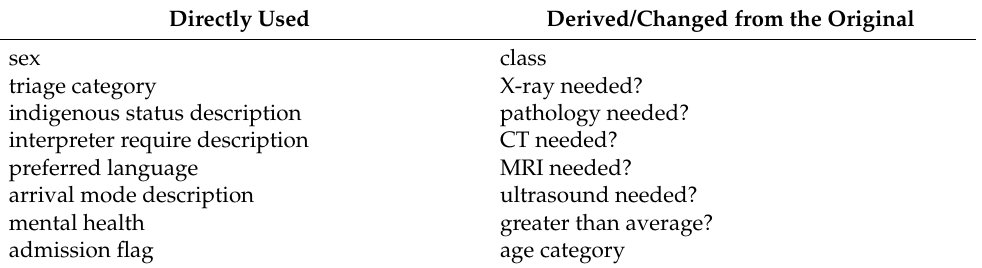
Table 1. Summary of Attributes Included in